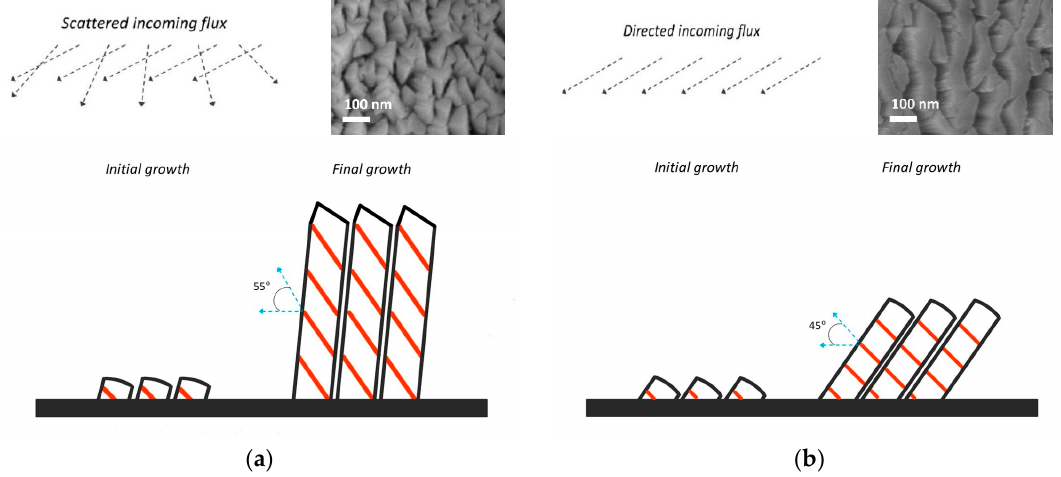
Figure 13. Illustrations of initial and final stages of AlN columnar film growth (with insets showing top-view SEM images of final column terminations and red lines representing c -axis tilt) at ( a ) 10 mTorr and ( b ) 1.5 mTorr.